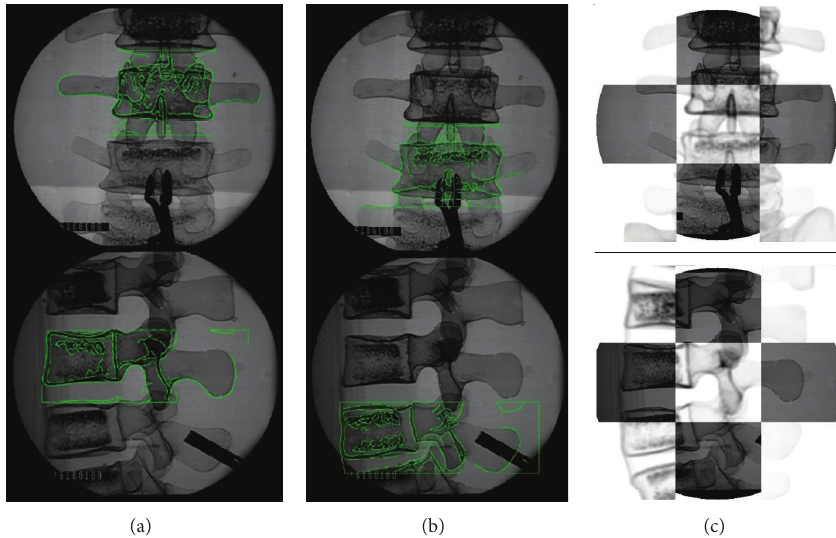
Figure 11: Visual validation of single-body registration without instrument (a) and with instrument (b) and superimposed images (c).